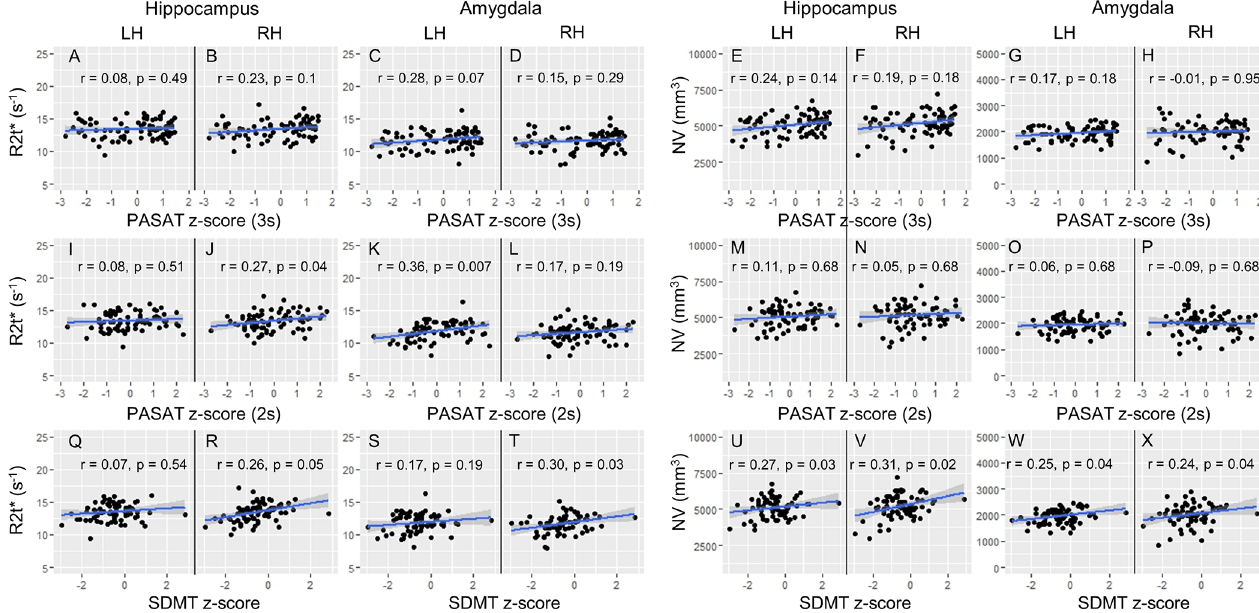
Fig 5. Correlations of R2t * and NV with clinical cognitive scores in hippocampus and amygdala of MS patients. Correlations of R2t * are shown on the left panels. Correlations of NV are shown on the right panels. Correlations with three clinical cognitivetests (3s PASAT, 2s PASAT and SDMT) are presented in 3 rows, respectively. The r-valuesand p-values (with FDR correction) are providedin each panel.LH = Left Hemisphere; RH = Right Hemisphere.